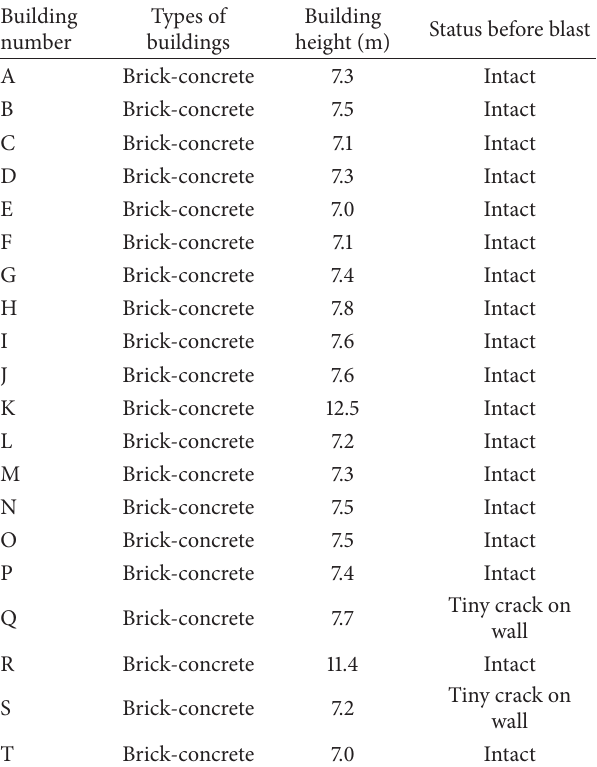
Table 1: The main parameters of the surrounding buildings of the blasting